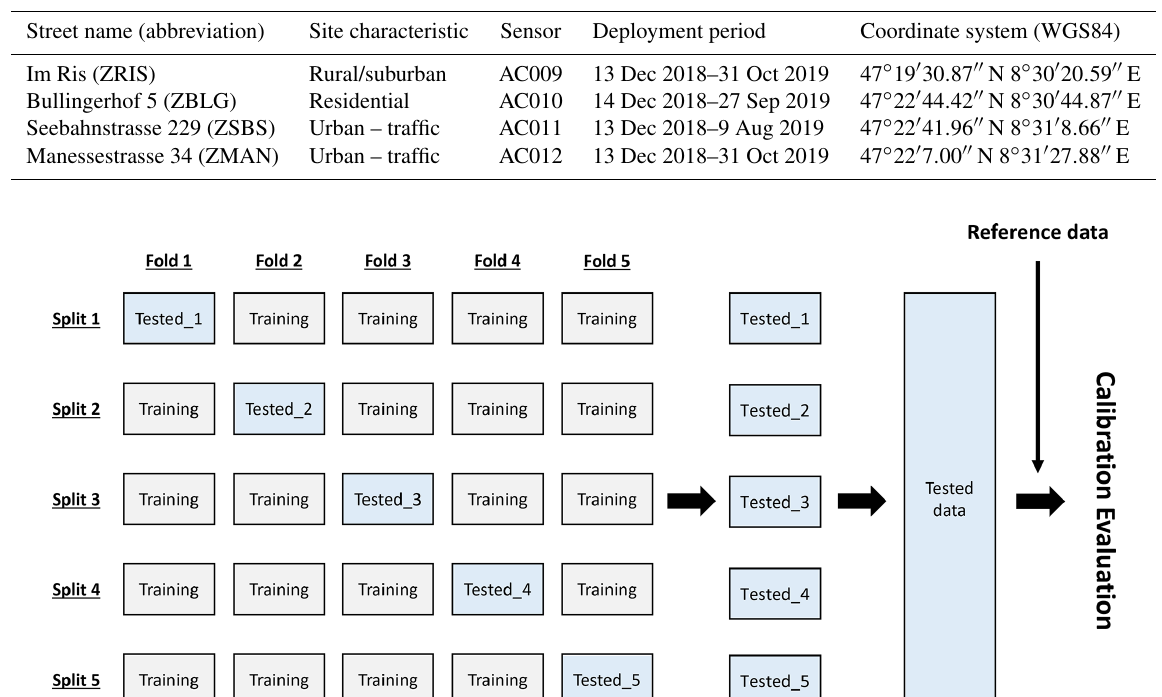
Figure 1. A scheme of the 5-fold cross validation utilized for the calibration model evaluation.